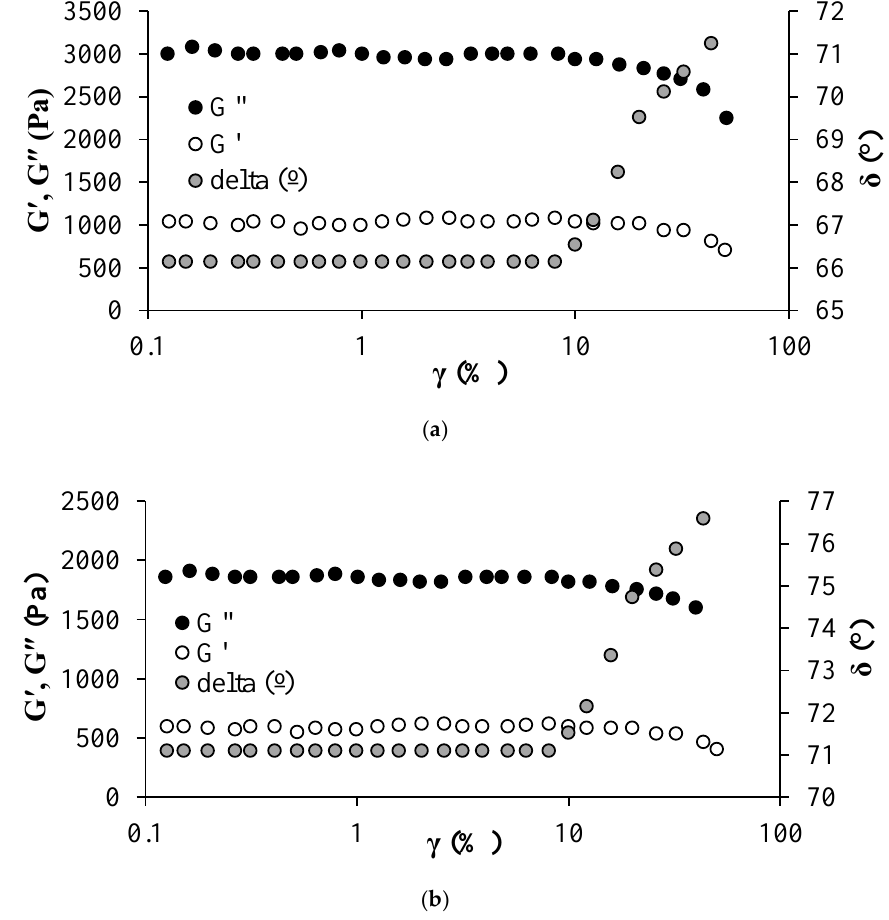
Figure 8. Amplitude sweep test for heavy oil in ( a ) absence and ( b ) presence of 500 mg/L of CFNS at a fixed frequency of 10 rad/s and a temperature of 25 °C.